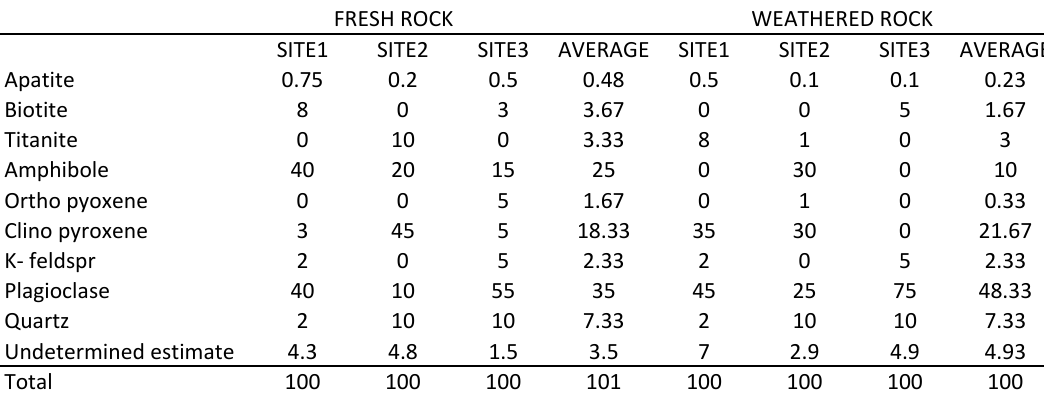
Table 1: Relative abundance of minerals in fresh and weathered rock at different sites (%) Table 1. Relative abundance of minerals in fresh and weathered rock at different sites